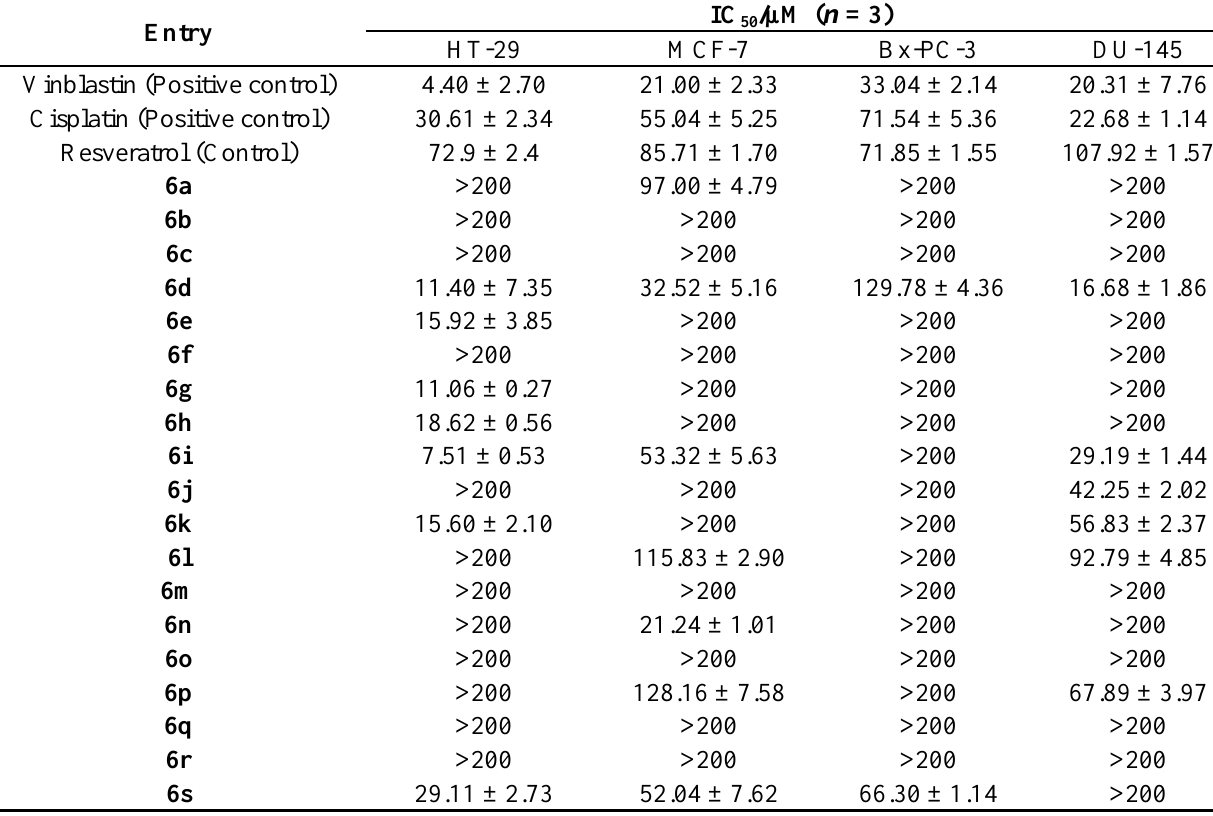
Table 1. Cytotoxic evaluation of o -carboxamido stilbenes on human cancer cell